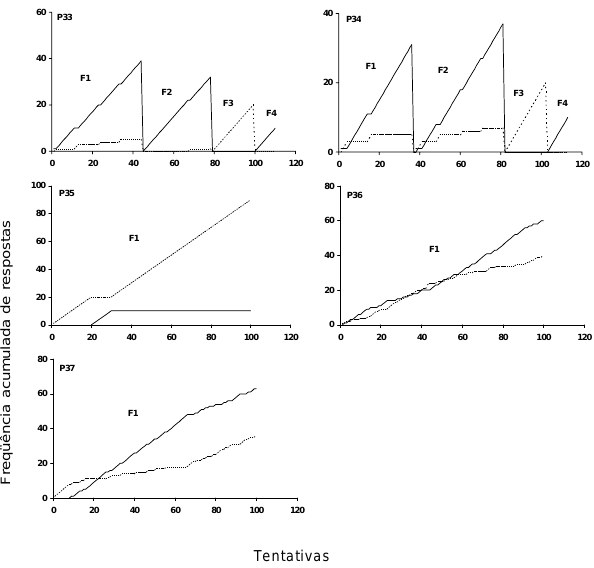
Figura 3 . Freqüência acumulada de respostas corretas (linha sólida) e incorretas (linha tracejada), para cada participante (P) da Condição 3, durante cada fase (F) experimental. Quebras na curva acumulada indicam mudanças de